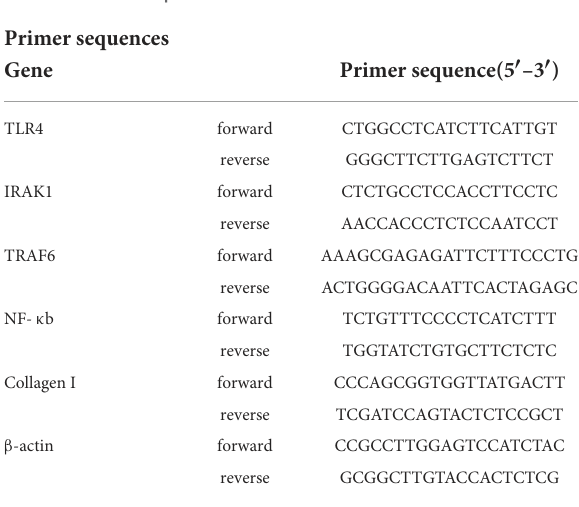
TABLE 2 Electrophysiological parameters. TABLE 3 Primer